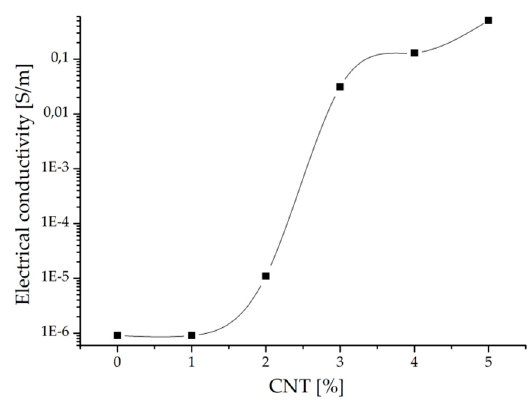
Figure 5. Percolation curve for ethylene–propylene–diene monomer (EPDM)/PP/CNT composites.